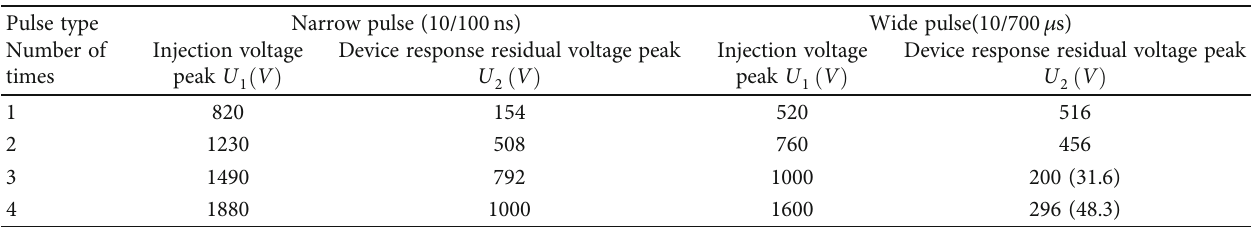
Table 2: Suppression ability of gas discharge tube to wide and narrow electromagnetic